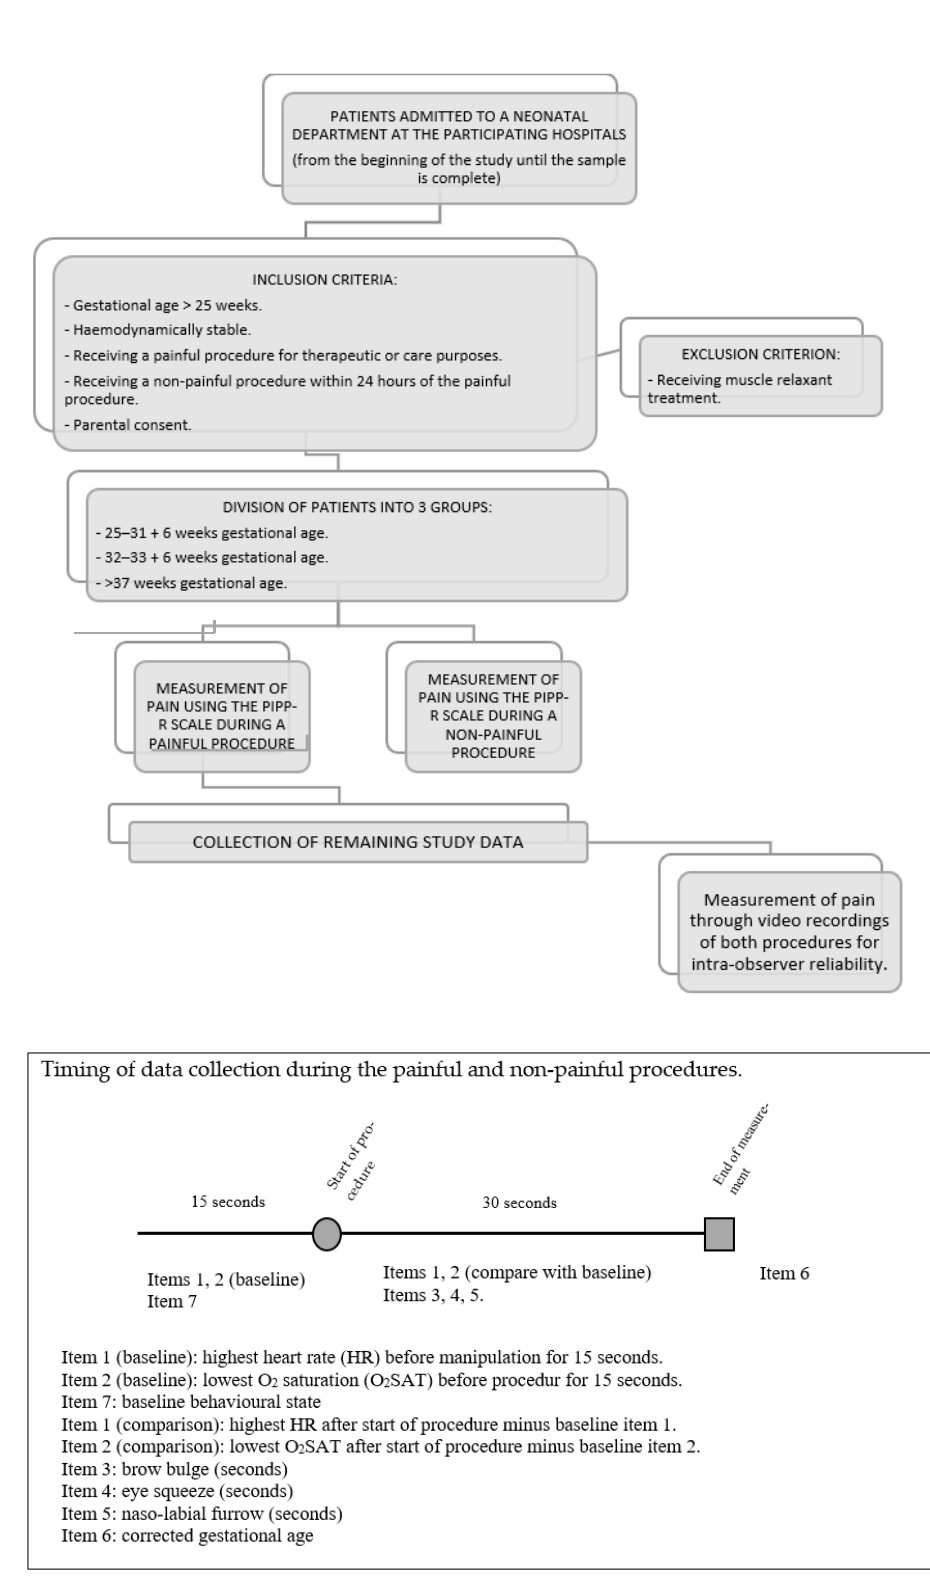
Figure 1. Data collection and timing diagram.